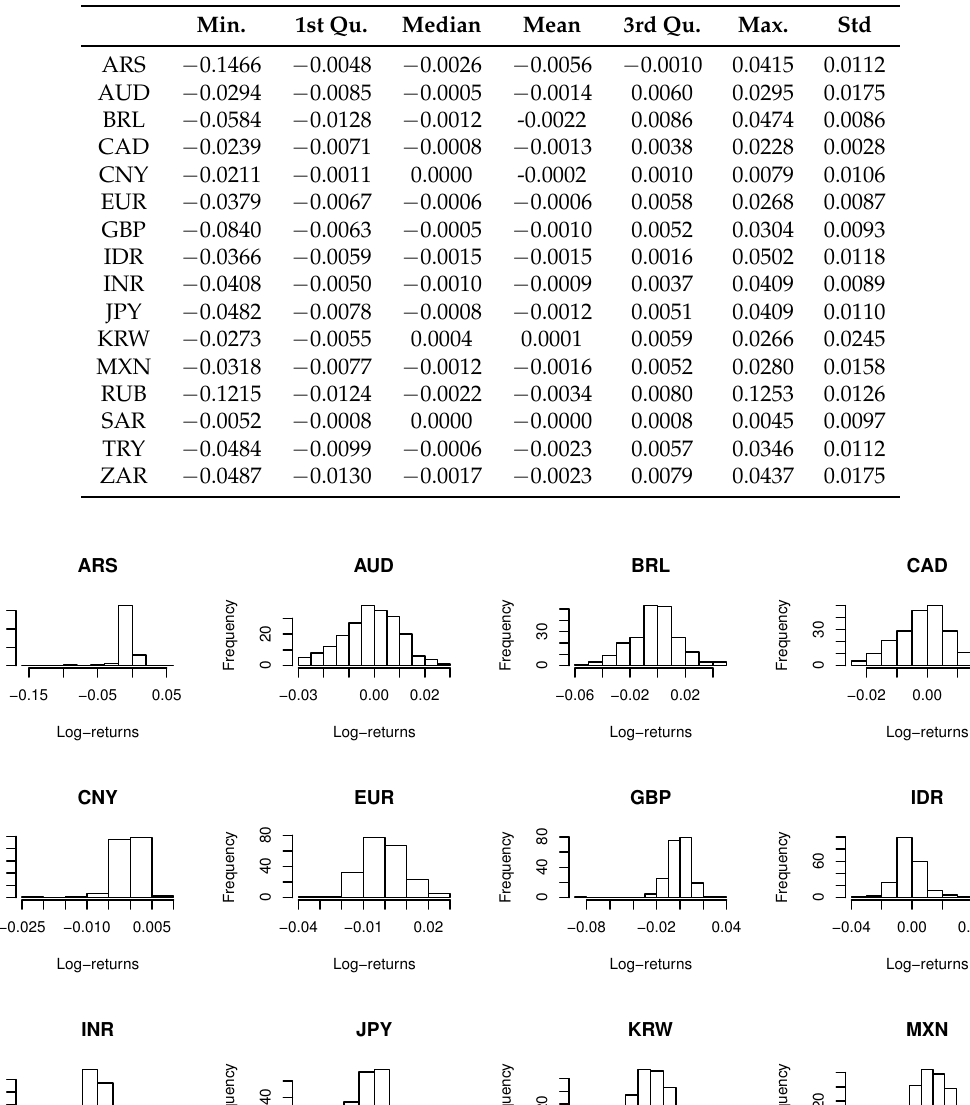
Table 3. Descriptive statistics of (log)returns of 16 selected currencies.